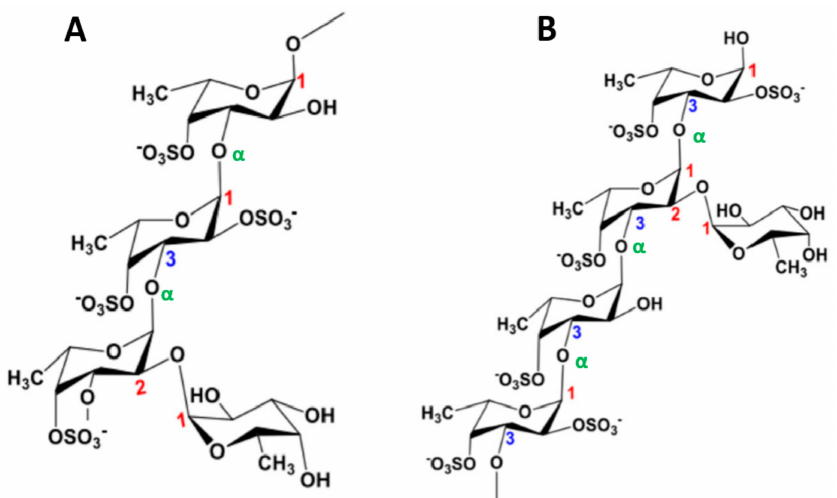
Figure 5. Structures of fucoidans from brown seaweeds of the Laminariales order. ( A ) Fucoidan from Laminaria saccharina composed of a main chain of (1 → 3)- α - l -Fuc p branched at O -2 and O -4 of α - l -Fuc p by terminal residues and sulfate groups. ( B ) Fucoidan obtained from Chorda filum consisting of a (1 → 3)- α - l -Fuc p main backbone highly ramified at O -2 by terminal residues and substituted by sulfate